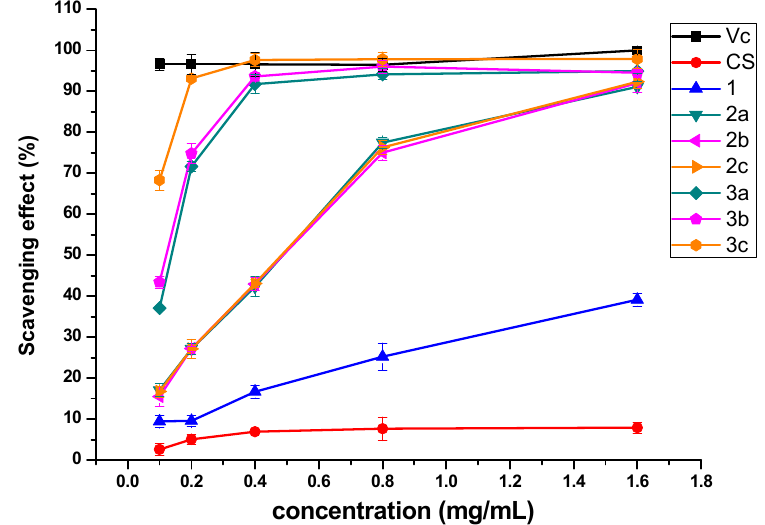
Figure 4. DPPH-radical scavenging activity of chitosan and chitosan derivatives.